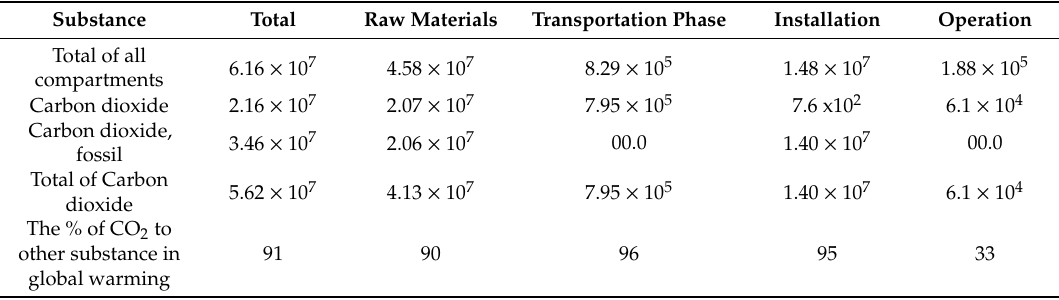
Table 9. Analyzing ‘TWF-Phases’; Method: TRACI / Characterization / Global Warming Category Unit (kg CO 2eq ).